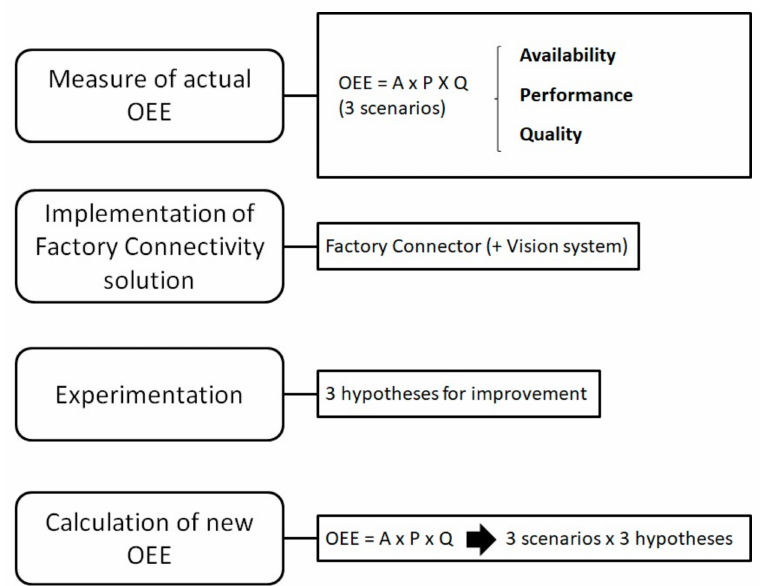
Figure 1. Steps involved in the methodology for experimentation and